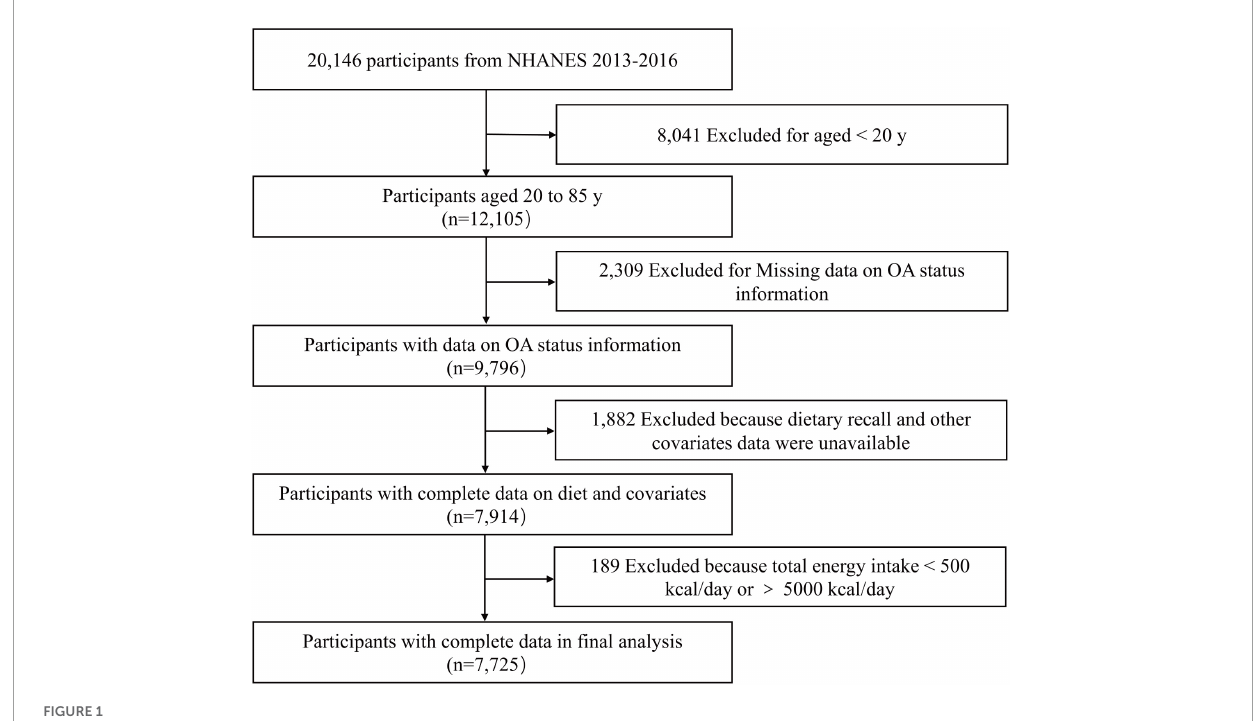
FIGURE1 Flowchart of the participants